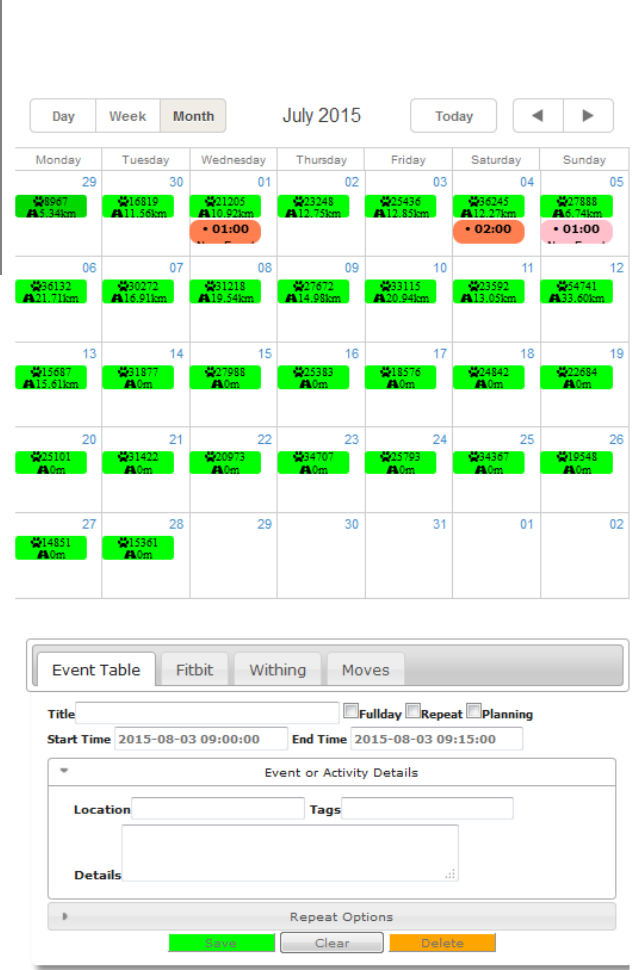
Figure 2 Example screenshot of dashboard